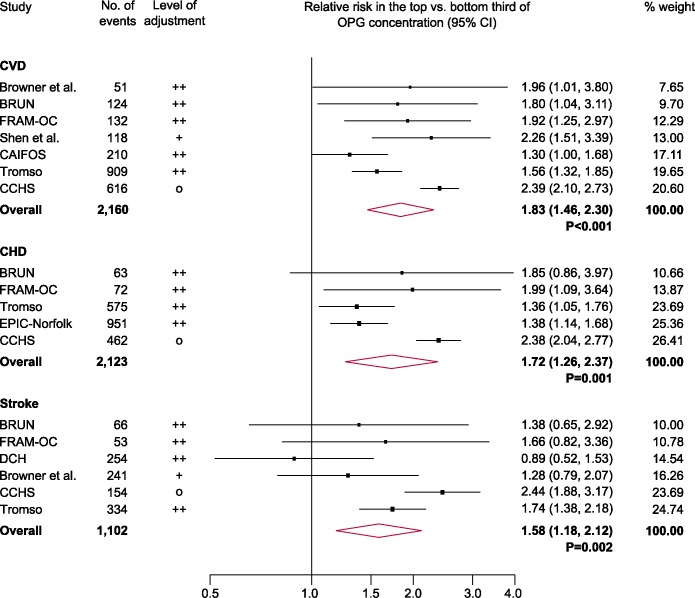
Combined relative risk for cardiovascular outcomes in the top vs. the bottom third of OPG concentration.CHD = coronary heart disease; CI = confidence interval; CVD = cardiovascular disease; OPG = osteoprotegerin. Full study names are listed in the footnote of Table 2. Sizes of data markers indicate the weight of each study in the analysis. Study-specific relative risks were pooled using random-effects meta-analysis.